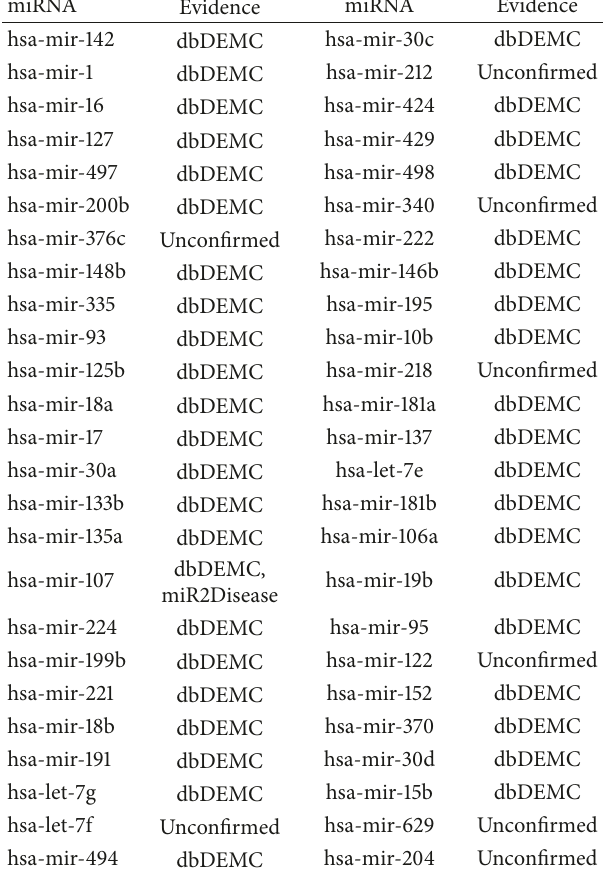
Table 2: We implemented CMFMDA to prioritize candidate miR- NAs for Kidney Neoplasms based on known associations in the HMDD database. As a result, 9 out of the top 10 and 41 out of the top50predictedKidneyNeoplasmsrelatedmiRNAswereconfirmed based on miR2Disease and dbDEMC (1st column: top 1–25; 2nd column: top